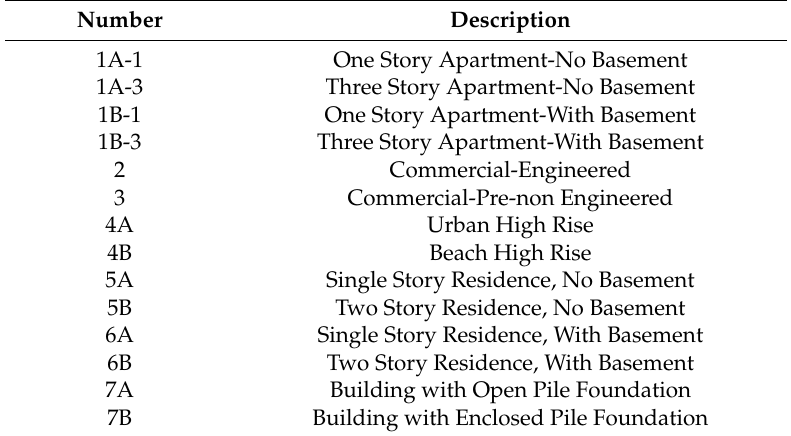
Table 1. ACOE NACCS (2015) [5] damage function prototype definition. Number